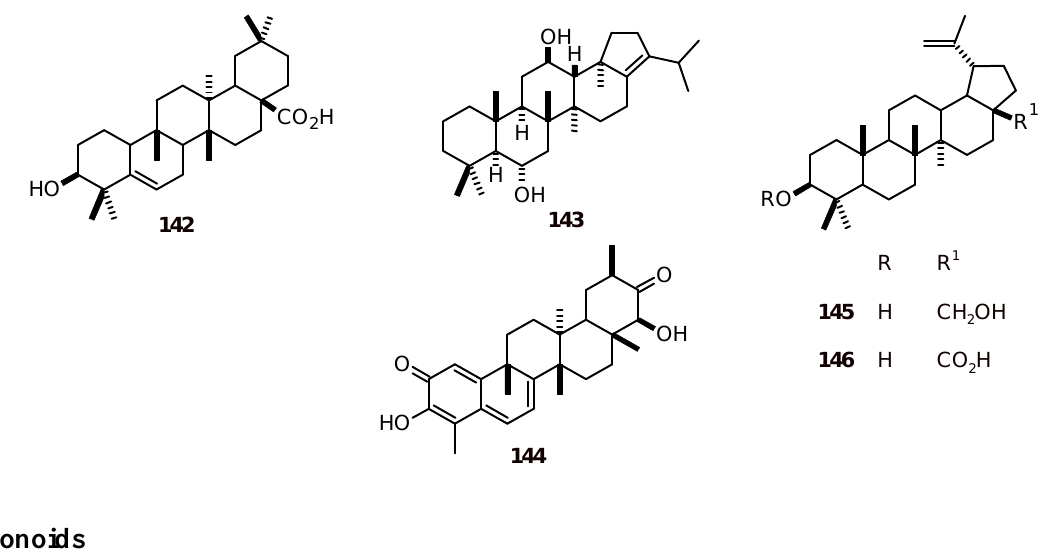
Figure 15. Structures of terpenes 142 - 146